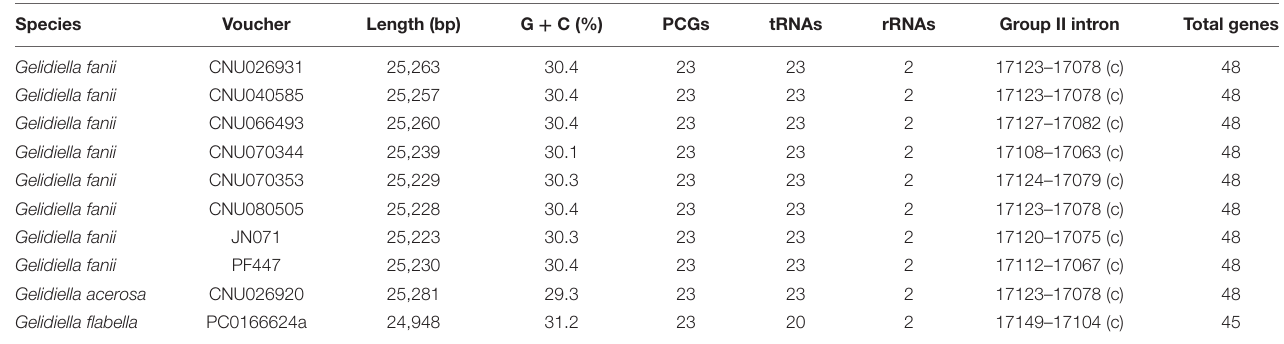
TABLE 1 | Characteristics of 10 complete mitogenomes of Gelidiella fanii , G. acerosa, and G. flabella . Species